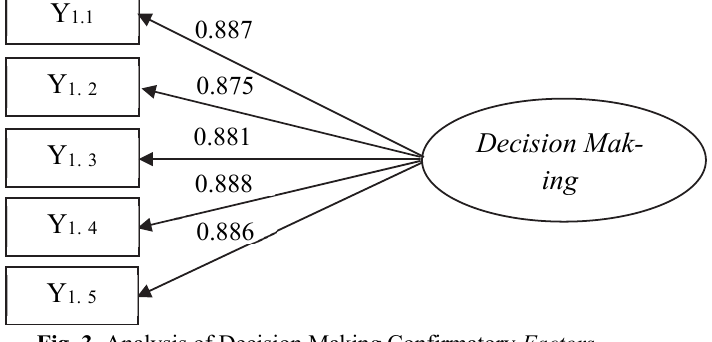
Fig. 3. Analysis of Decision Making Confirmatory Factors